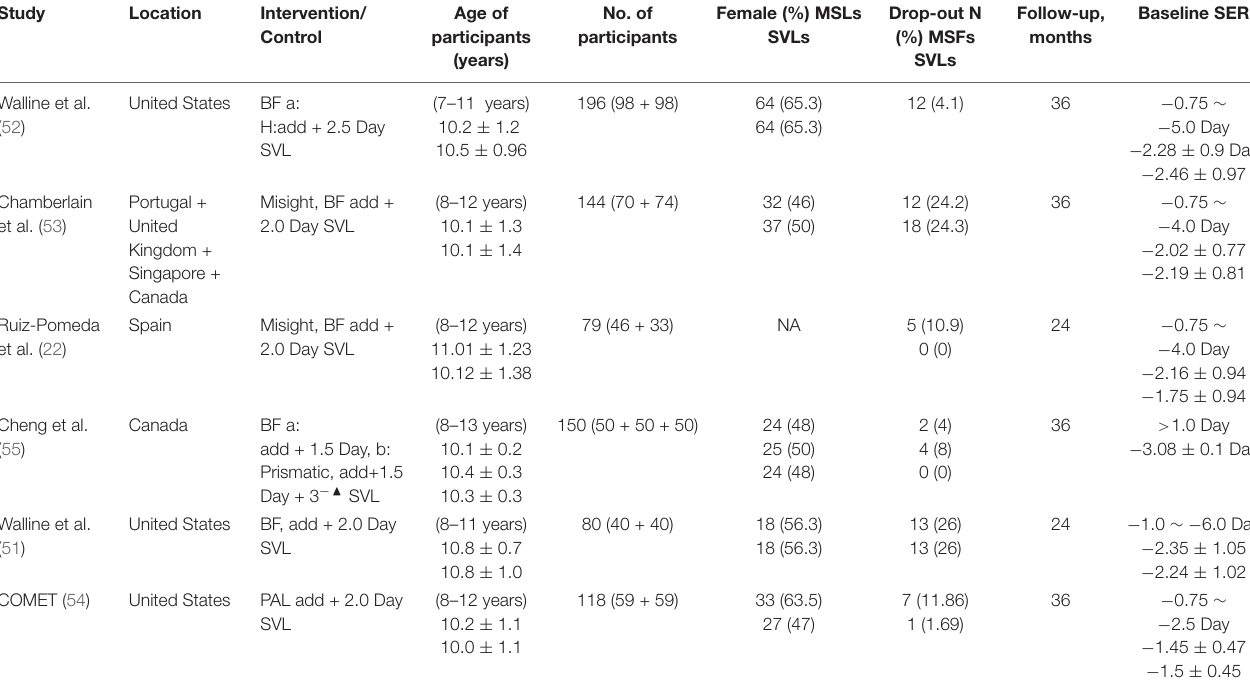
TABLE 1 | Characteristics of included annual-visit studies in